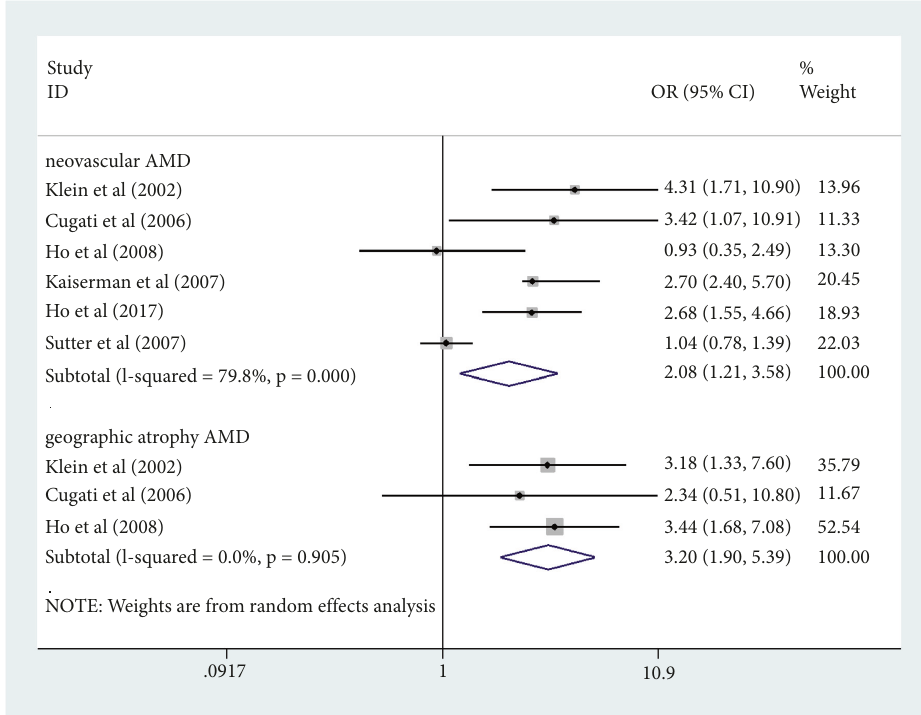
Figure 3: Forest plot evaluating the association between cataract surgery and the development of late age-related macular degeneration (AMD) based on AMD